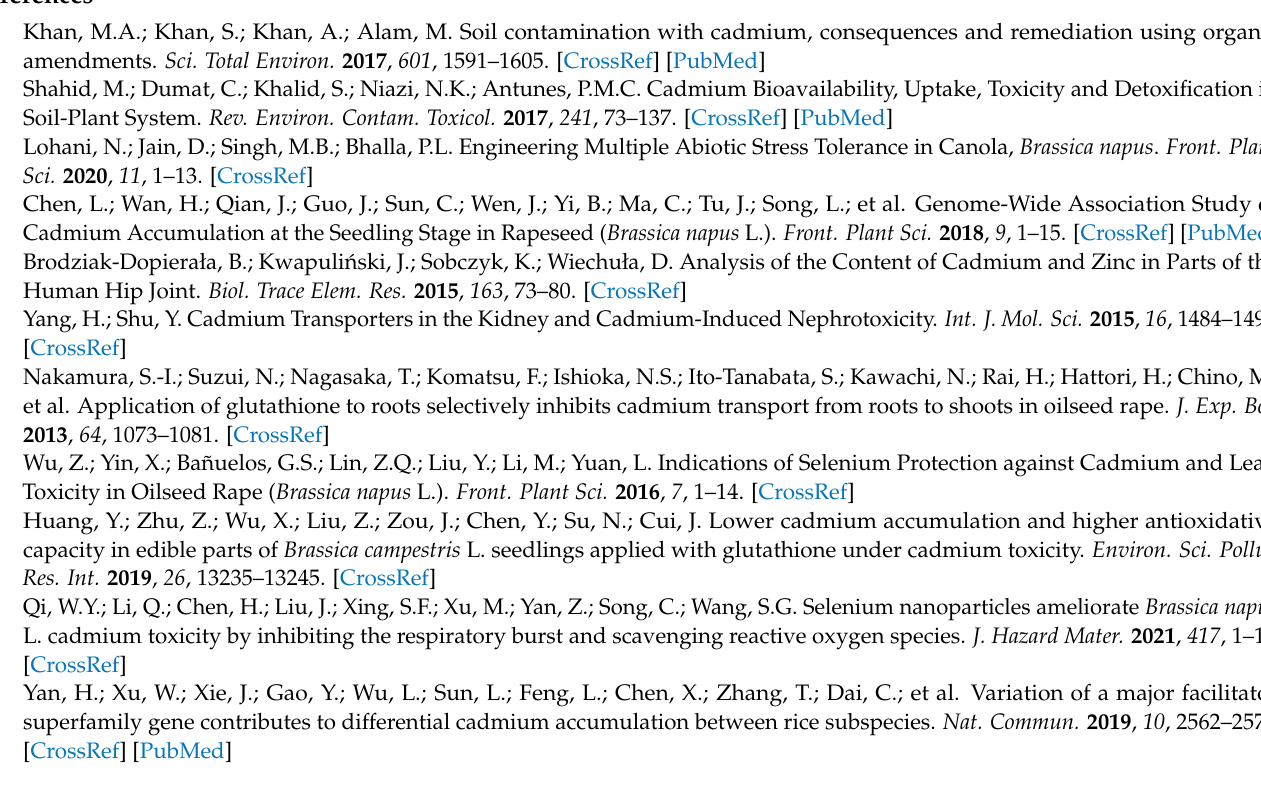
of AtCUP1. Figure S3: Display of editing results of AtCUP1 -editing lines ( CR-1 , CR-2 and CR-3 ). Figure S4: Cadmium localization in the root and hypocotyl tissues of CRISPR-AtCUP1 lines exposed to 0 or 60 µ M Cd for 7 d. Figure S5: Alignment of CUP1 homolog sequences identified from A. thaliana ( AtCUP1 ) and B. napus ( BnCUP1-1a , BnCUP1-1b , BnCUP1-1c and BnCUP1-1d ). Figure S6: Relative expression levels of each copy of BnCUP1 . Figure S7: Display of editing results of BnCUP1 gene editing lines ( CRISPR-S12 and CRISPR-S34 ). Table S1: Primers used in the present study. Table S2: Detection of potential off-target sequences. Table S3: Detection of physical and chemical properties of the soil. Table S4: Statistics of agronomic characters of three lines grown in the control